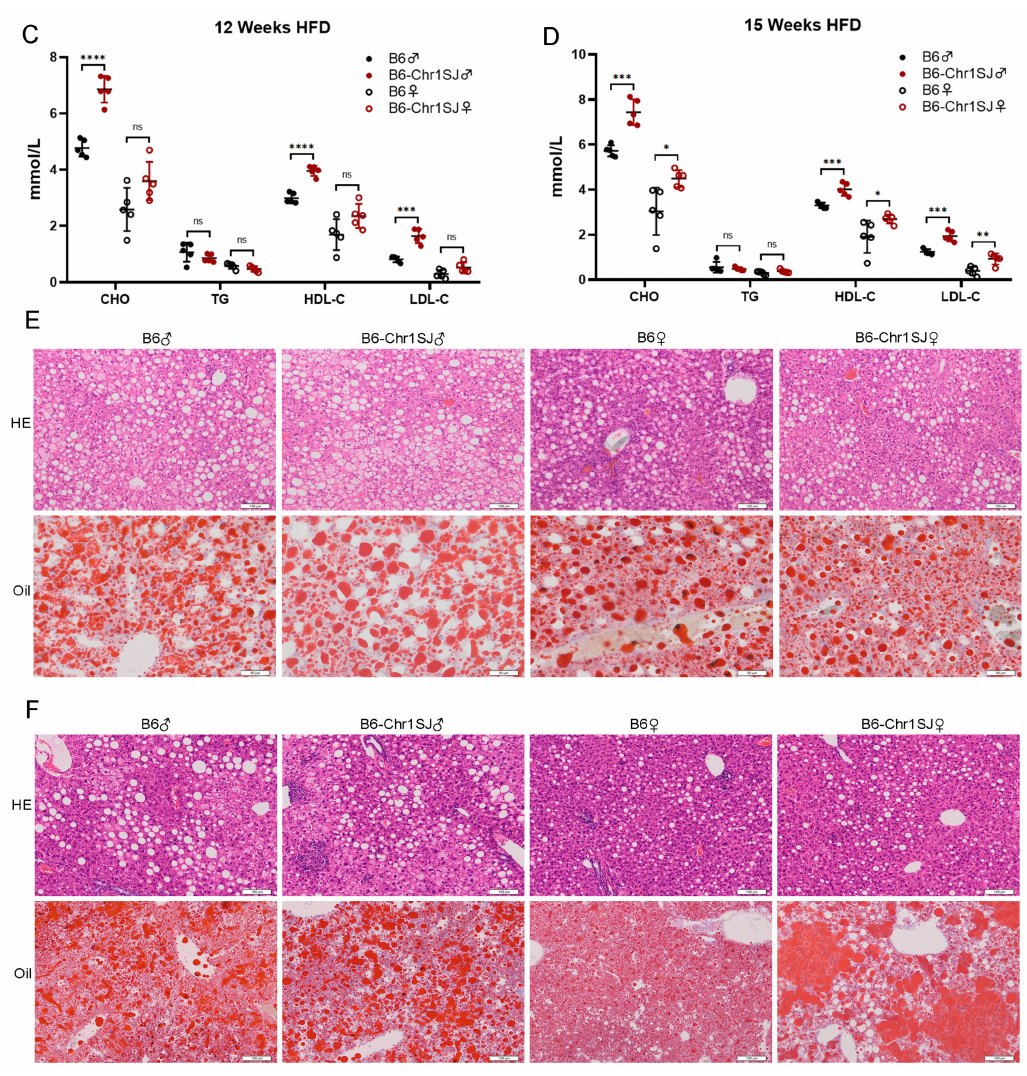
Figure 1. HFD-fed B6-Chr1SJ line showed significant abnormalities in body weight, lipid metabolism and liver lesions. ( A ) Average body weight trajectory in HFD-fed male mice ( n = 5 per group). ( B ) Average body weight trajectory in HFD-fed female mice ( n = 4–5 per group). ( C ) The serum lipid levels (CHO, TG, HDL-C, and LDL-C) of 20-week-old C57BL/6J and B6-Chr1SJ mice (HFD fed for 12 weeks) ( n = 5 per group). ( D ) The serum lipid levels (CHO, TG, HDL-C, and LDL-C) of 23-week-old C57BL/6J and B6-Chr1SJ mice (HFD fed for 15 weeks) ( n = 5 per group). ( E ) The representative H&E and Oil Red O staining in liver sections of 36-week-old C57BL/6J and B6-Chr1SJ mice (HFD fed for 28 weeks). Scale bars (H&E staining) = 100 µ m. Scale bars (Oil Red O staining) = 50 µ m. ( F ) The representative H&E and Oil Red O staining in liver sections of 43-week-old C57BL/6J and B6-Chr1SJ mice (HFD fed for 35 weeks). Scale bars (H&E staining) = 100 µ m. Scale bars (Oil Red O staining) = 100 µ m. ( A – D ) Data are presented as the mean ± SD. T -test: * p < 0.05, ** p < 0.01, *** p < 0.001, **** p < 0.0001. ns = not significant. HE: hematoxylin-eosin staining. Oil: Oil Red O staining. CHO: total cholesterol. TG: triglycerides. HDL-C: high-density lipoprotein cholesterol. LDL-C: low-density lipoprotein cholesterol. : female. : male. ♀ ♂ 3.2. HFD-fed B6-Chr1LY Line Showed Significant Abnormalities in Body Weight,